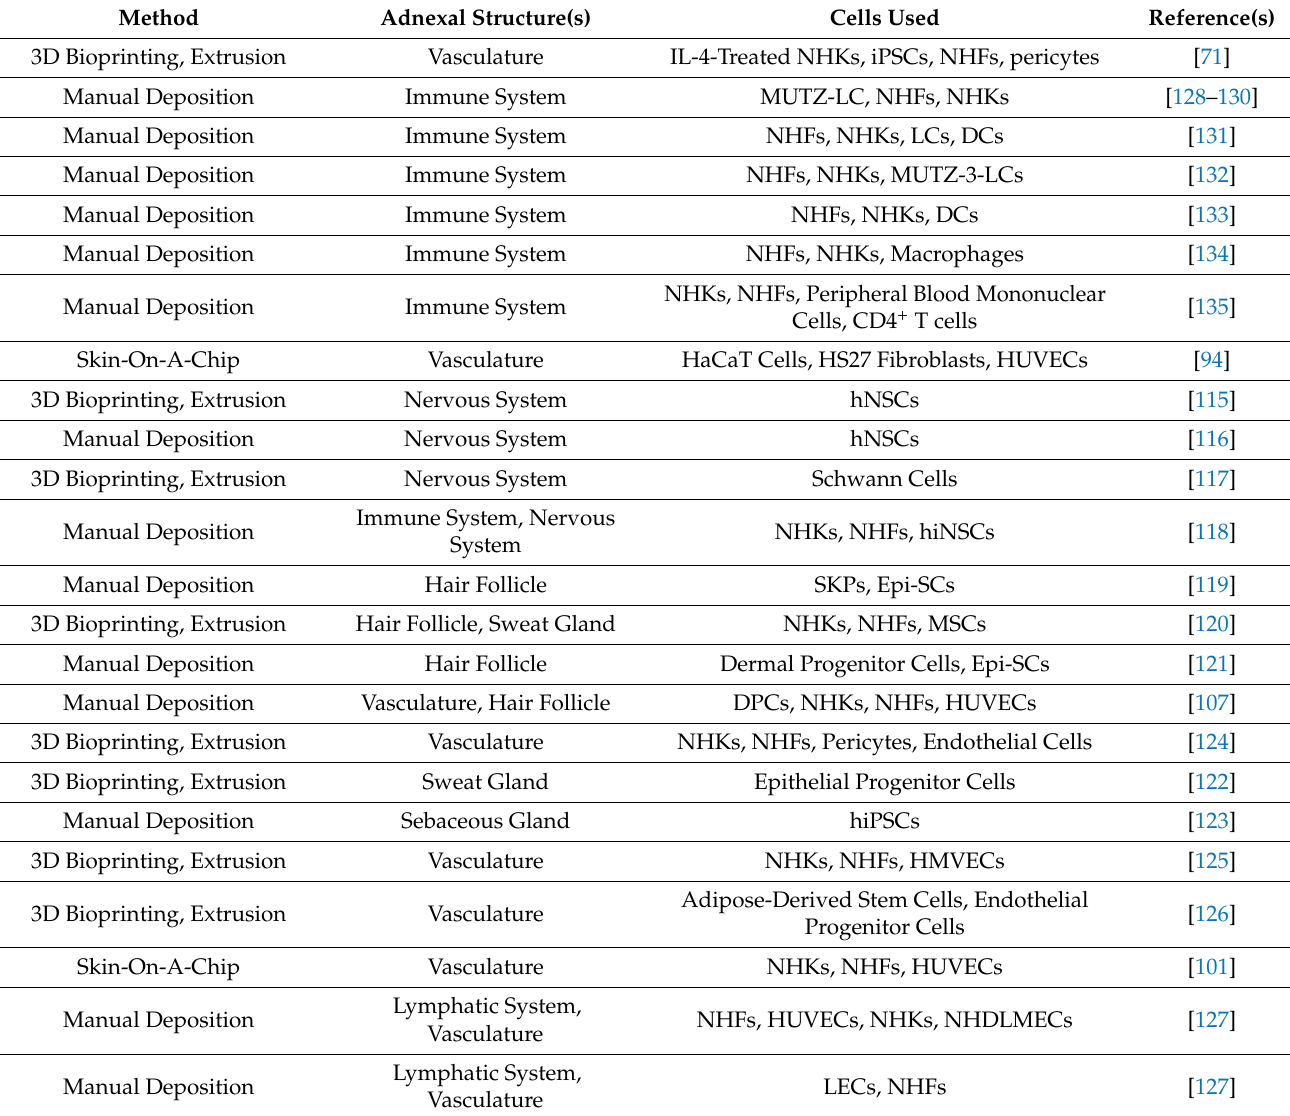
Table 2. Current 3D HSE models with adnexal structures and methods used for their